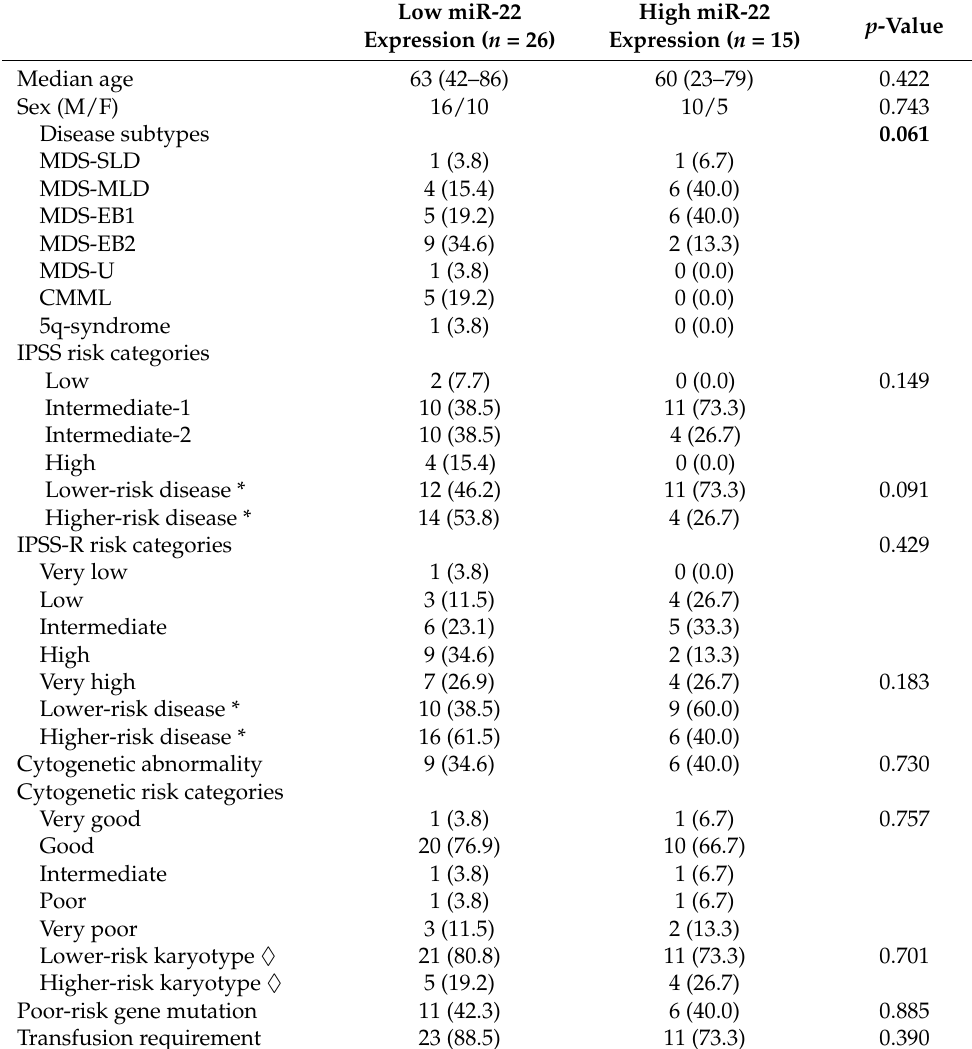
Table 3. Baseline characteristics according to miR-22 expression